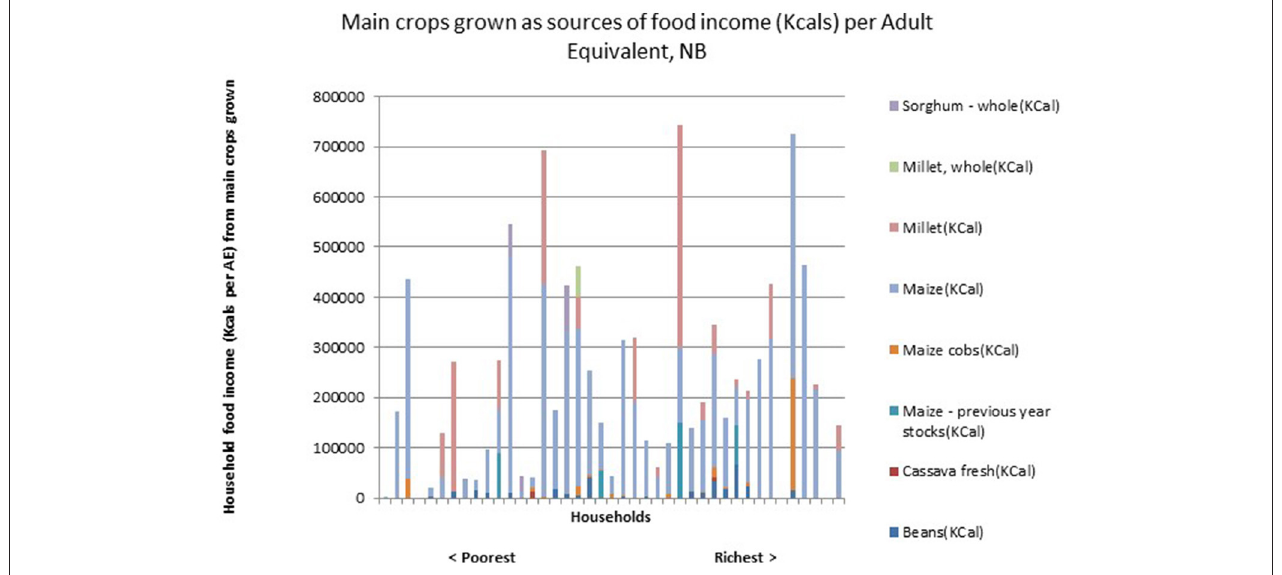
FIGURE 6 | Breakdown of main crops grown and retained for household